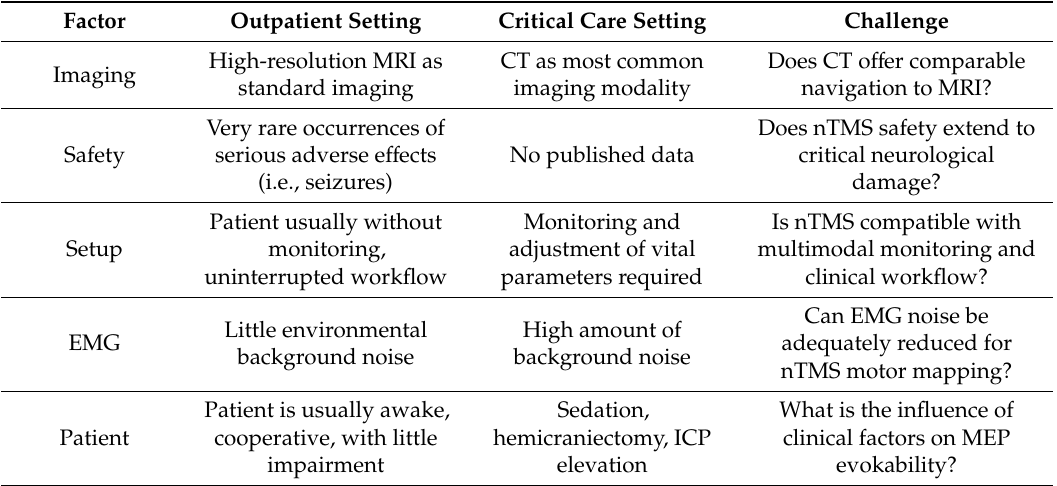
CT as most common Does CT o ff er comparable imaging modality navigation to MRI? Does nTMS safety extend to No published data critical neurological damage? Is nTMS compatible with Monitoring and multimodal monitoring and adjustment of vital clinical workflow? parameters required Can EMG noise be High amount of adequately reduced for background noise nTMS motor mapping? What is the influence of Sedation, clinical factors on MEP hemicraniectomy, ICP elevation